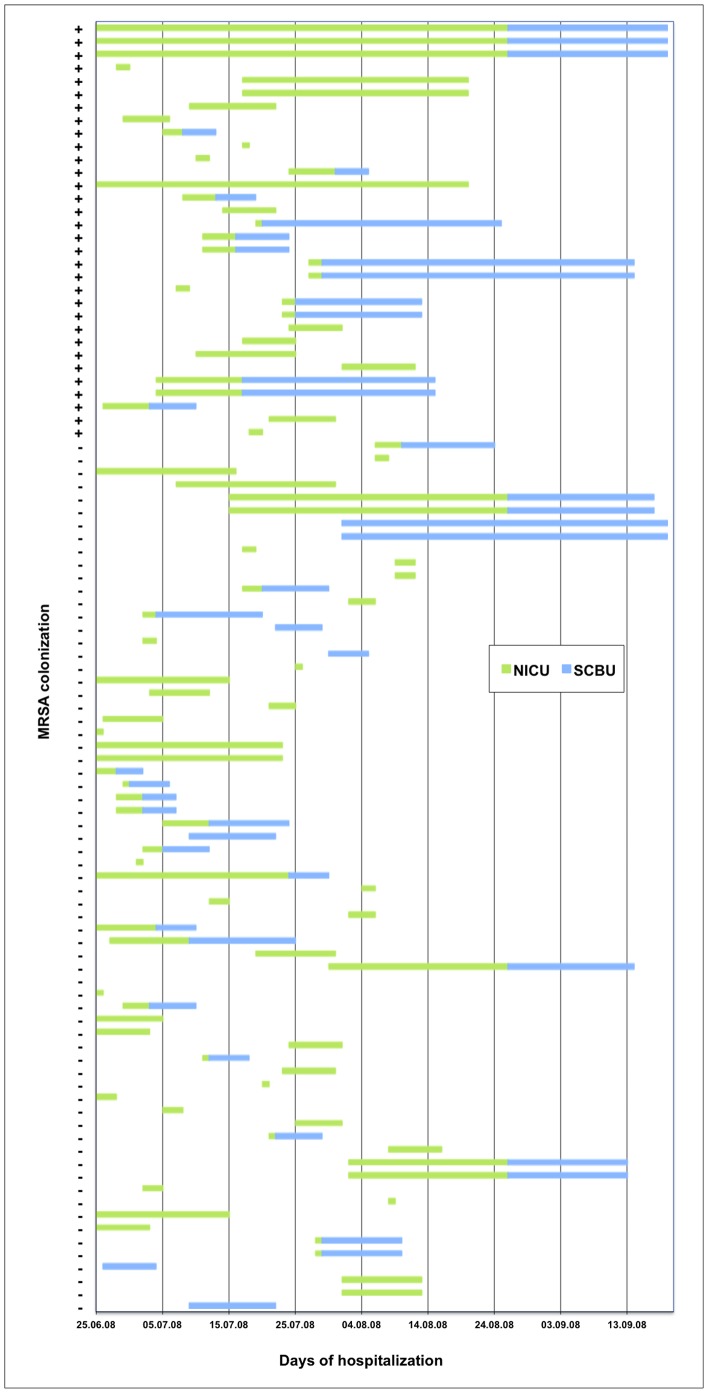
Time course of MRSA outbreak at the 2 neonatal wards.The figure shows the time period of hospitalization for each individual neonate at NICU (green) and SCBU (blue). The first 32 lines (marked with a+sign) are the MRSA colonized neonates and non-colonized neonates are marked with a - sign.